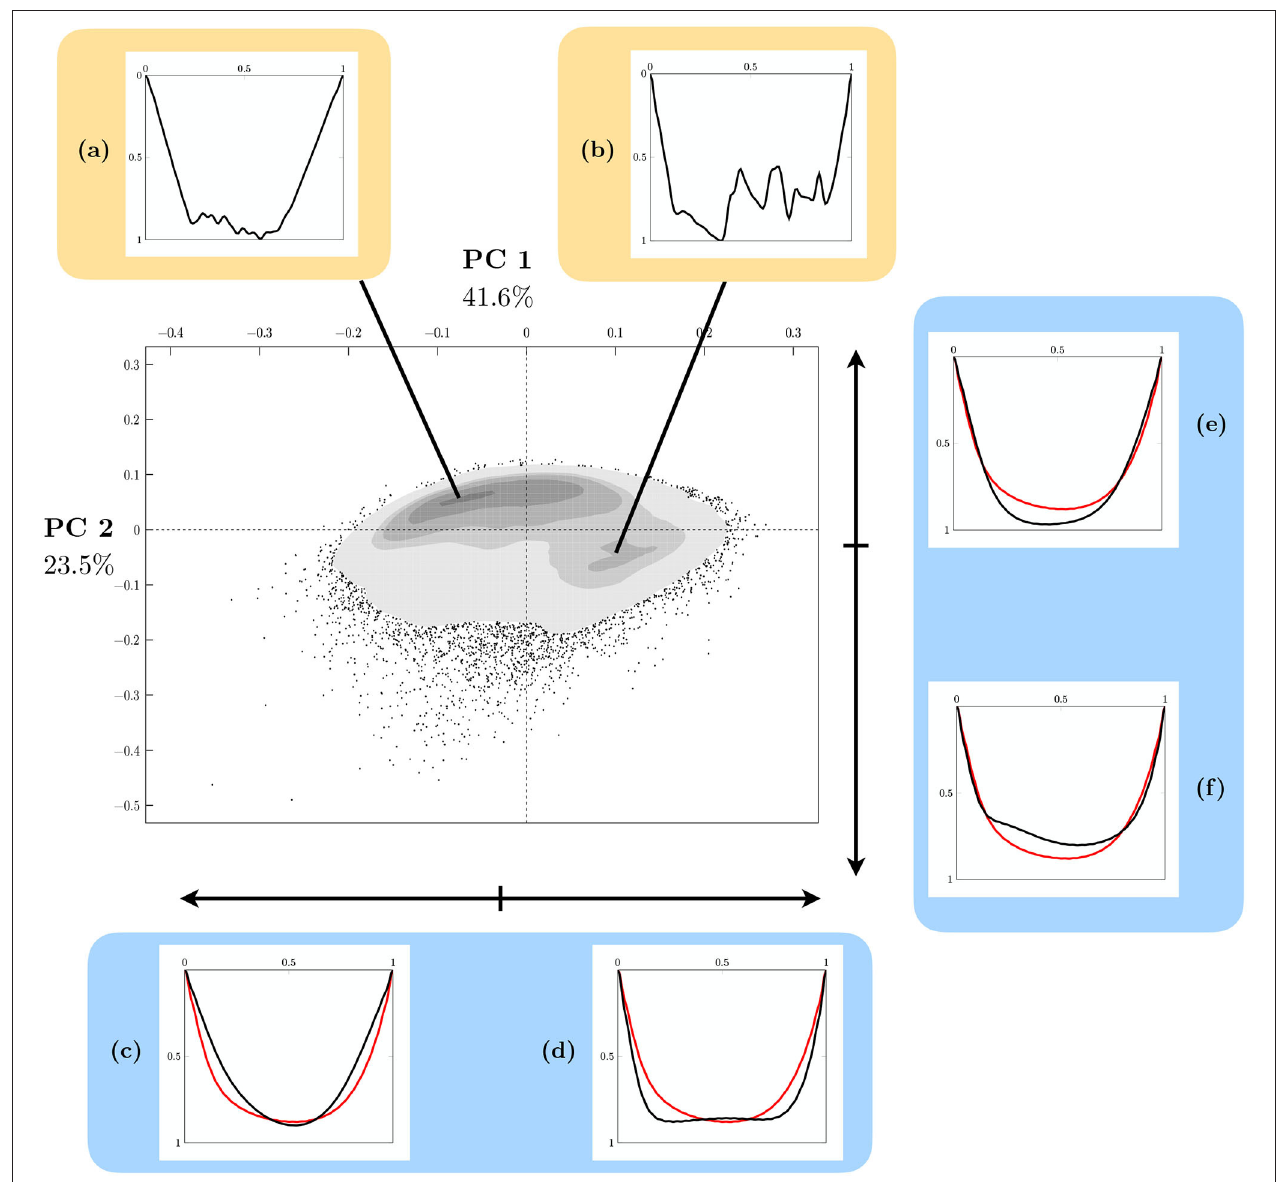
FIGURE 8 | Kernel density display of the 2D FPCA map of dives of southern elephant seals. It accounts for 65.1 % of the entire shape variability. The successive gray surfaces increasingly darker correspond to those containing, respectively 2.5, 25, 50, 75, and 97.5 % of the data centered around local density maximums. Black points are those that escape the 97.5 % area. At the top, normalized sample dives corresponding to the closest curves to the local maximums of density (a,b) . At the bottom, representation of the influence of the first factorial axis (41.6 % of explained variance) on the shape of the normalized curves (c,d) . On the right, the influence of the second one (23.5 % variance explained) (e,f) . Red curves correspond to the mean curve. Black curves represent the deformation generated by the corresponding factor.